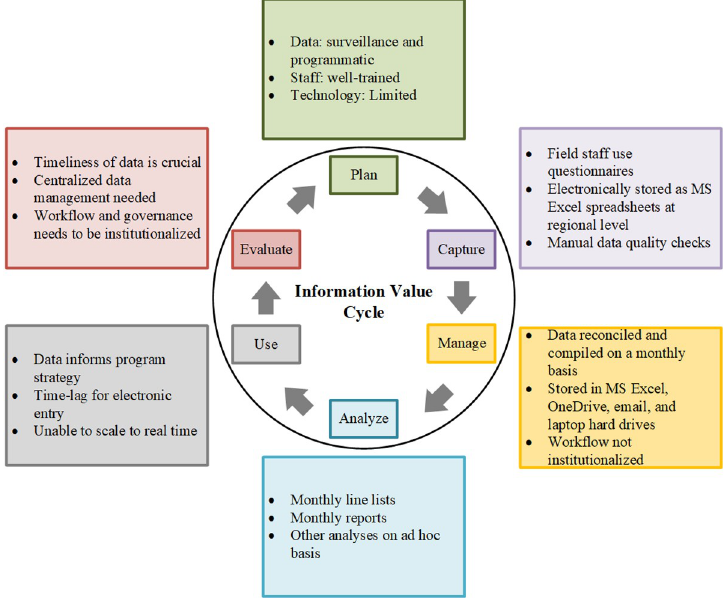
Fig 4. Information Value Cycle representing the information collected, people and processes involved, tools, and outcomes of the information